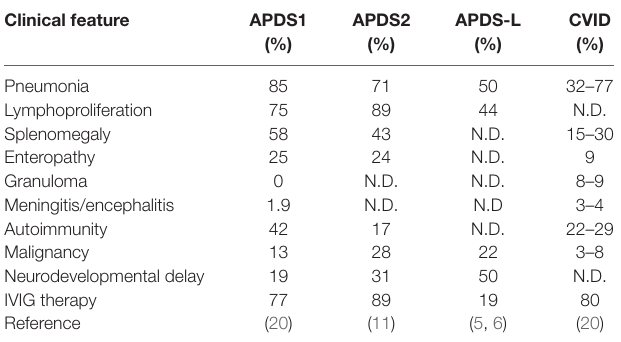
TaBle 1 | Clinical features of patients with APDSs, APDS-L, or CVID. clinical